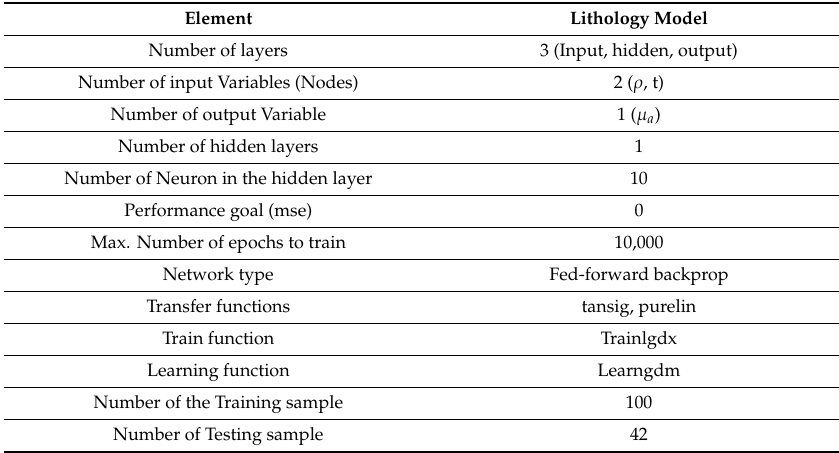
Figure 7. Schematic diagram of artificial neural network topology used for the apparent viscosity ( µ a ) prediction model as a function of mud density ( ρ ) and march funnel viscosity ( t ). Table 4. Characteristics of the training networks for the lithology determination model.